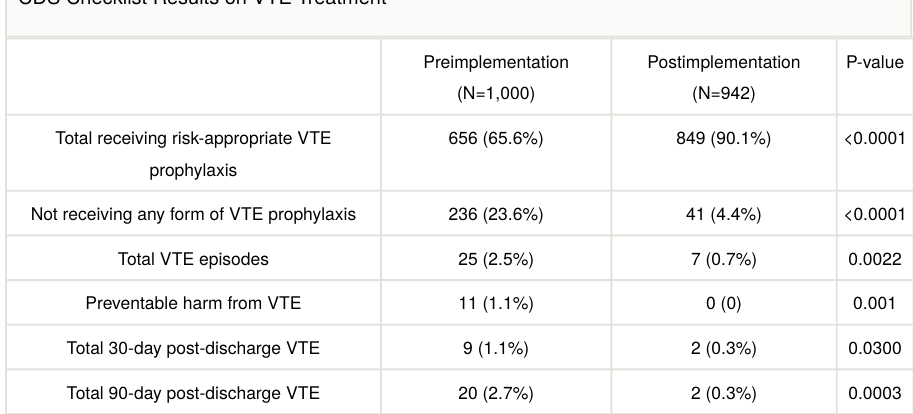
CDS Checklist Results on VTE